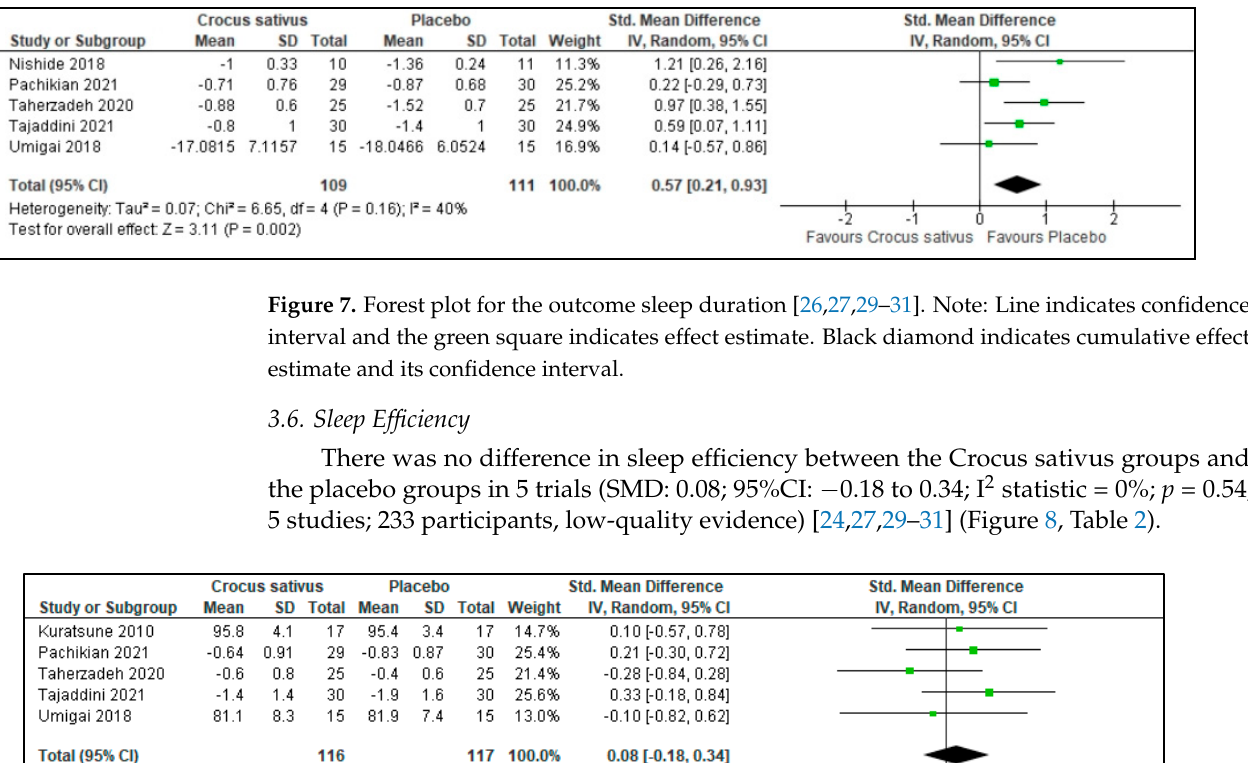
10 of 16 Figure 6. Forest plot for the outcome sleep latency [26,27,29,30]. Note: Line indicates confidence interval and the green square indicates effect estimate. Black diamond indicates cumulative effect